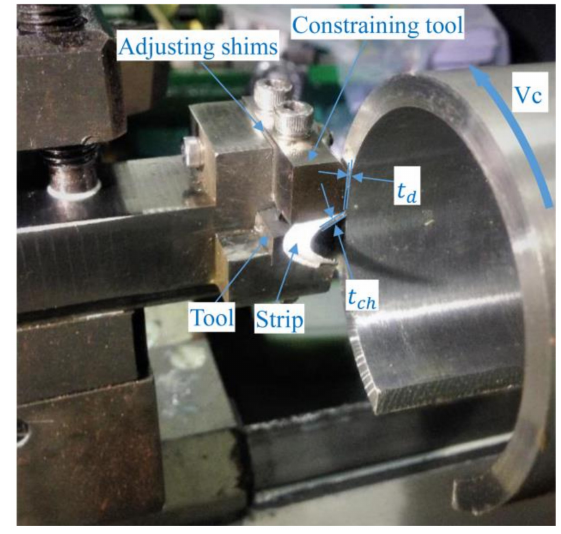
Figure 2. Experimental setup of LSEM and corresponding geometric